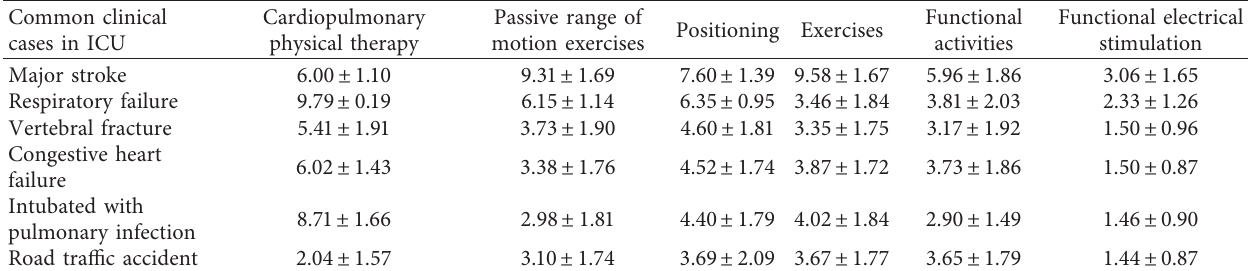
Table 3: Preferred physical therapy approach in